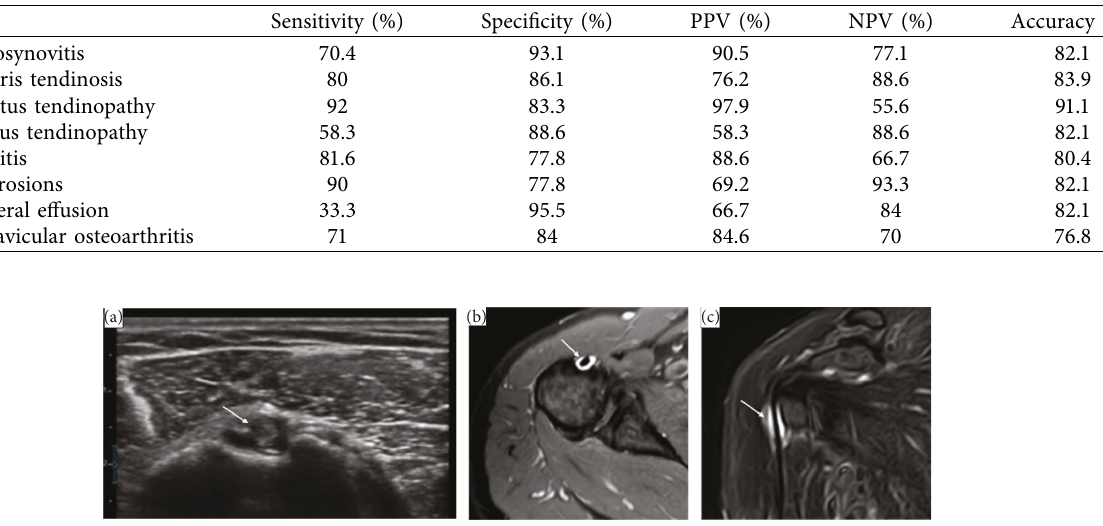
Figure 1: US and MRI findings of 50-year-old female patient with 4-year hemodialysis duration, presenting with shoulder pain for 6 month. (a) US scan transverse view of biceps tendon shows a hypoechoic area around the biceps tendon (arrow) denoting tenosynovitis. (b & c) MRI shoulder axial &coronal STIR images revealed mild amount fluid SI within synovial sheath of biceps tendon (arrow) denoting biceps tenosynovitis.